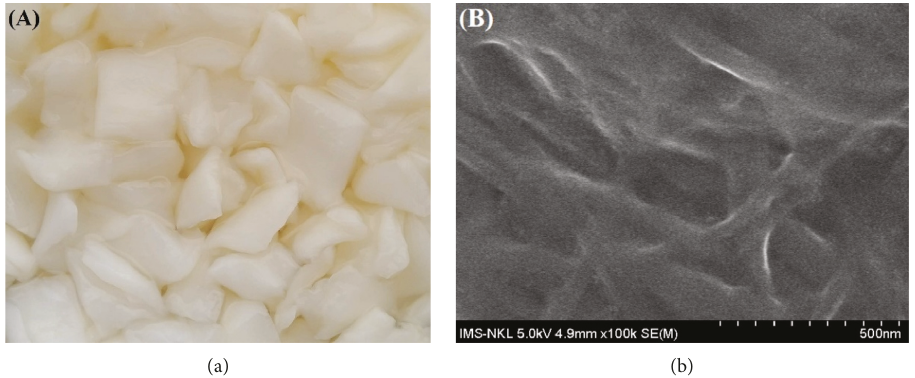
Figure 3: Scanning electron micrographs of bacterial cellulose, native (b); nata de coco (a).